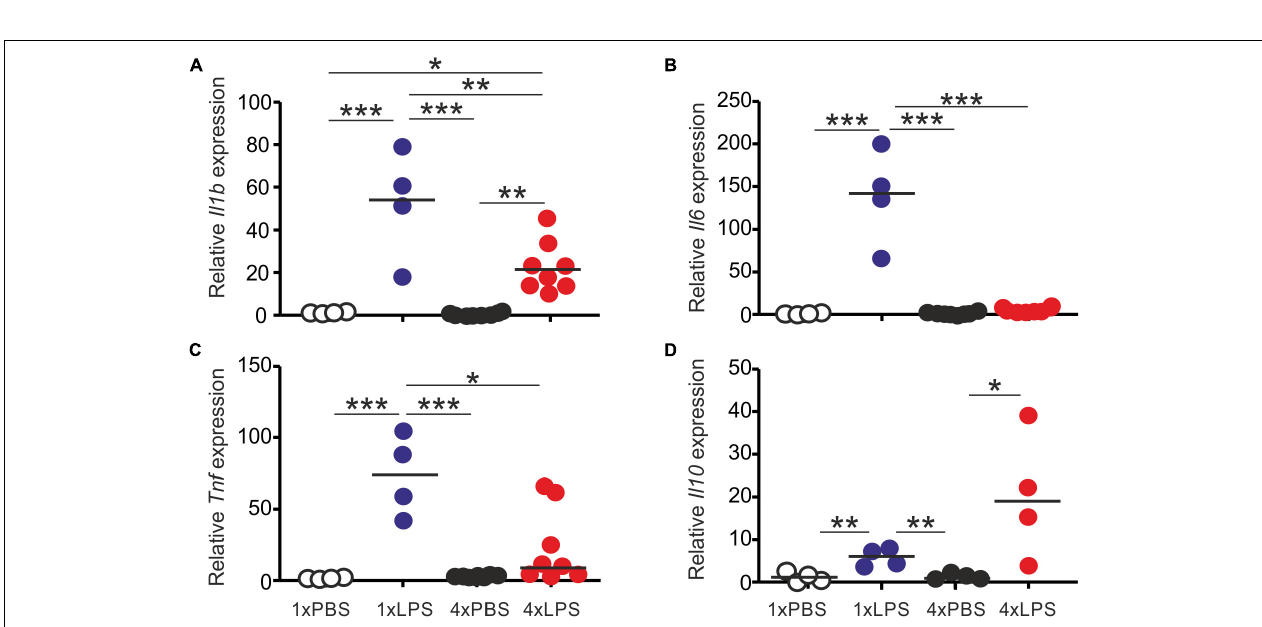
FIGURE 2 | Effect of systemic LPS treatment on expression of cytokine-encoding genes in the brain. Mice were given a single (1x) or four (4x) daily IP injections with either LPS or PBS (control). Brains were collected 3 h after the final injection and gene expression compared by RT-qPCR analysis. (A) Relative expression level of Il1b mRNA. (B) Relative expression level of Il6 mRNA. (C) Relative expression level of Tnf mRNA. (D) Relative expression level of Il10 mRNA. Gene expression data are normalized so that the mean level in the 1xPBS controls was 1.0. N = 4–8 mice/group; horizontal bar, median. * P < 0.05; ** P < 0.01; *** P < 0.001.